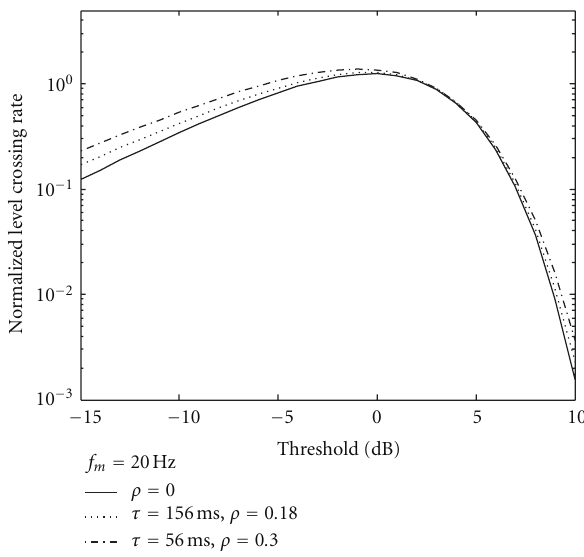
Figure 4: Normalized LCR for σ 2 1 = σ 2 2 =